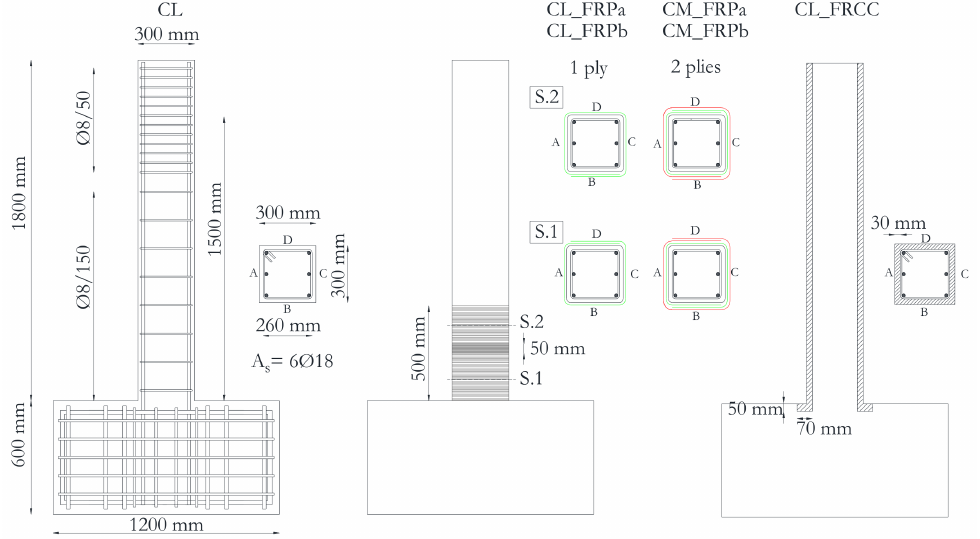
Figure 1. Specimens’ geometry and strengthening configurations.